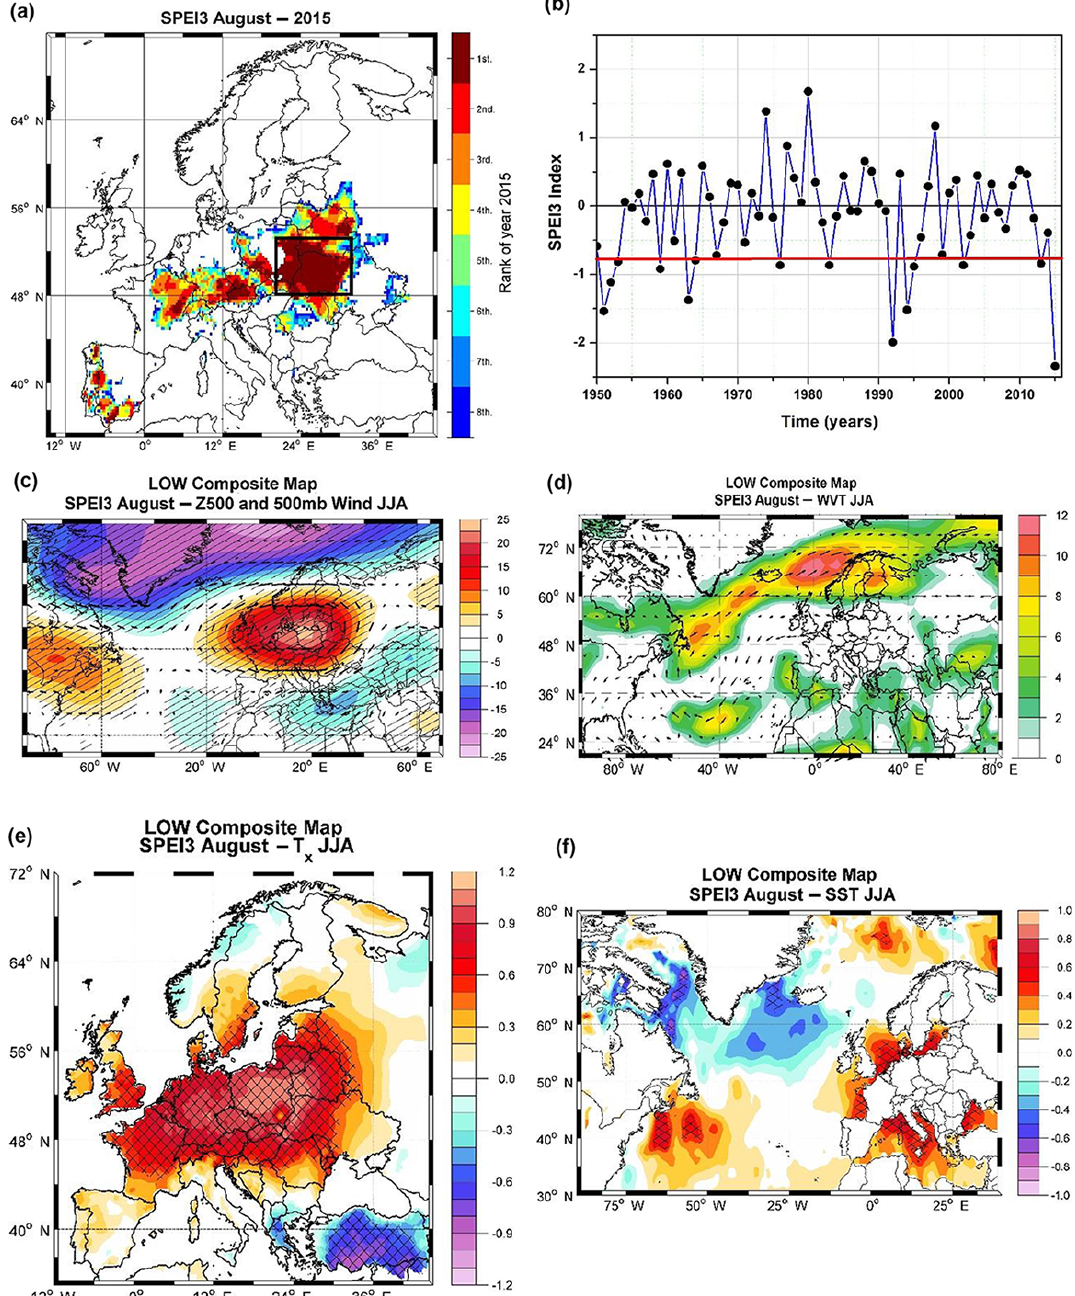
Figure 10. (a) Top-eight ranking of 2015 August SPEI3. (b) The time series of August SPEI3 index averaged over the black box in (a) . (c) The low (SPEI3 August index ≤ 0.75 standard deviation) composite map between the August SPEI3 index and the JJA Z500 and the wind vectors at 500mb; (d) the same as (c) but for the JJA WVT; (e) is the same as (c) but for the JJA T x and (f) is the same as (c) but for the JJA SST. Units: Z500 (m), WVT (kgms − 1 ) , T max ( ◦ C) and SST ( ◦ C). The hatching highlights significant values at a confidence level of 95%. Analyzed period: